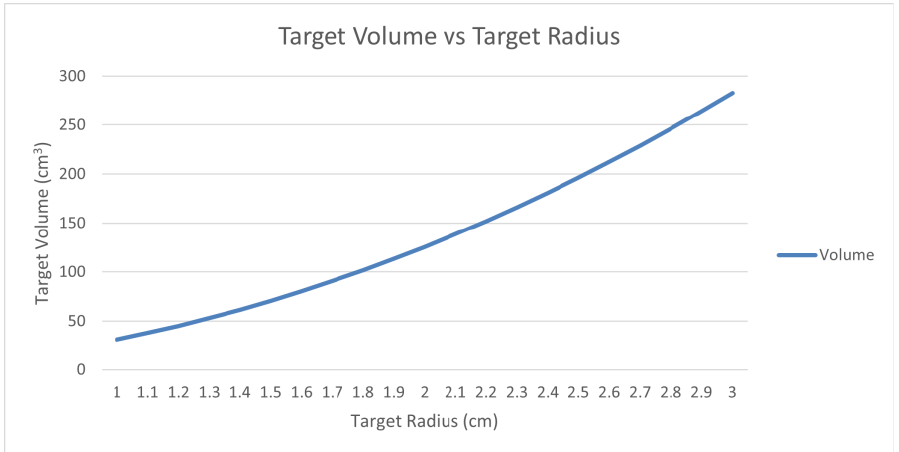
Figure 2. 1% enriched target with height 10 cm and target volume compared to radius plotted.